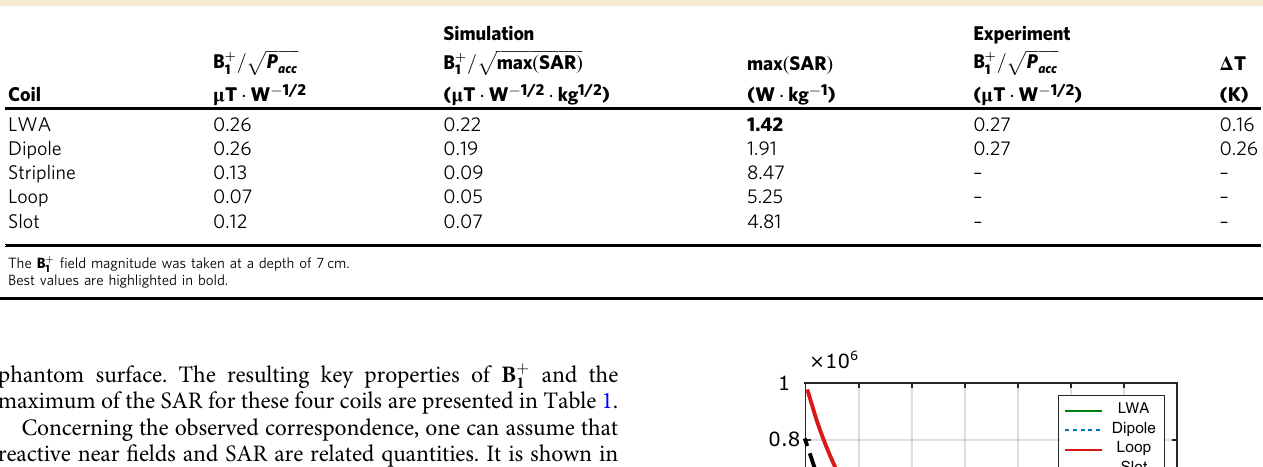
transmit and local SAR ef fi ciencies for different coils placed on a homogeneous 1